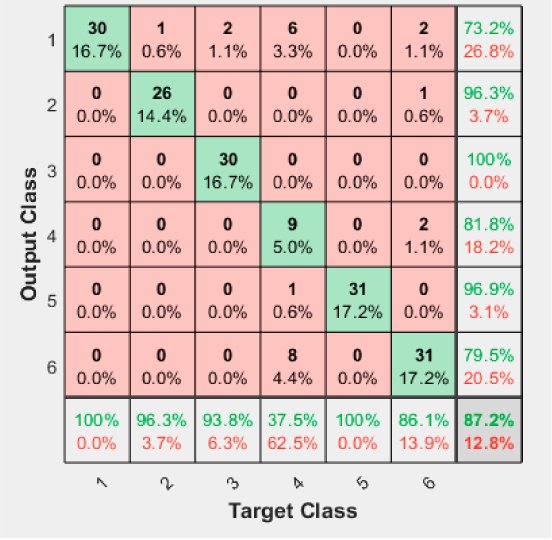
Figure 9. Confusion matrix for classification model with db1